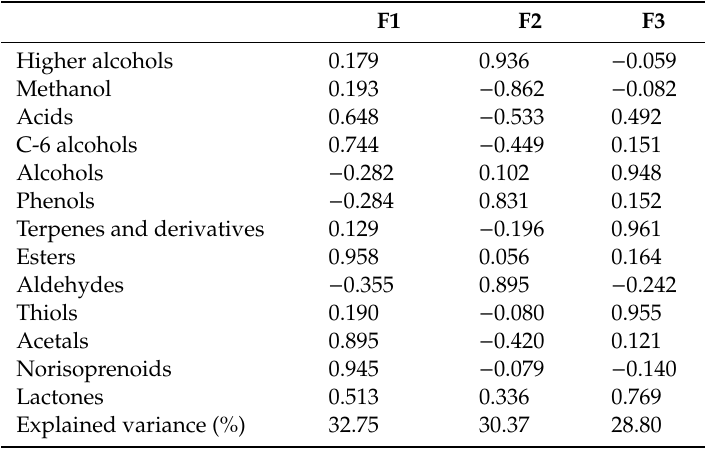
Table 2. Loadings of the main components of the volatile compounds in Tintilla de Rota dosed with bee pollen and control